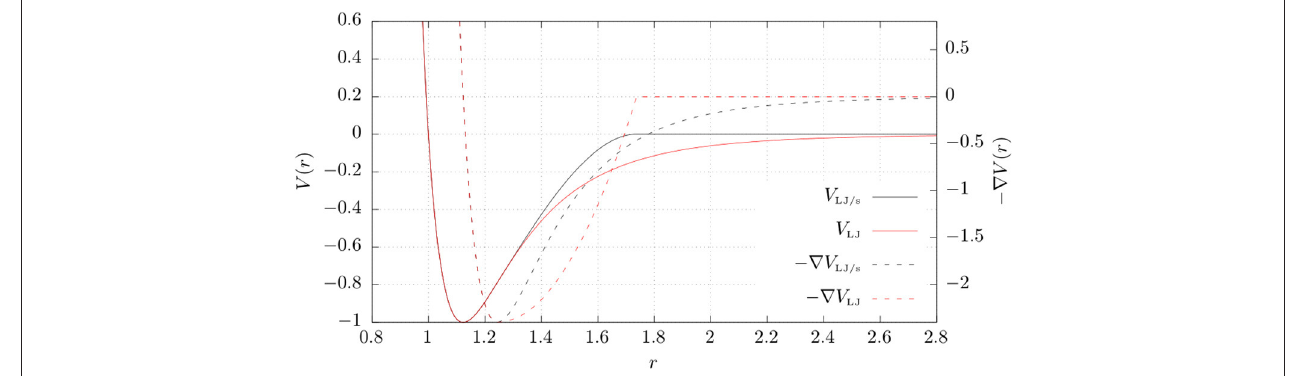
FIGURE 1 | The Lennard-Jones/spline potential and the untruncated Lennard-Jones potential, plotted along with their corresponding forces.